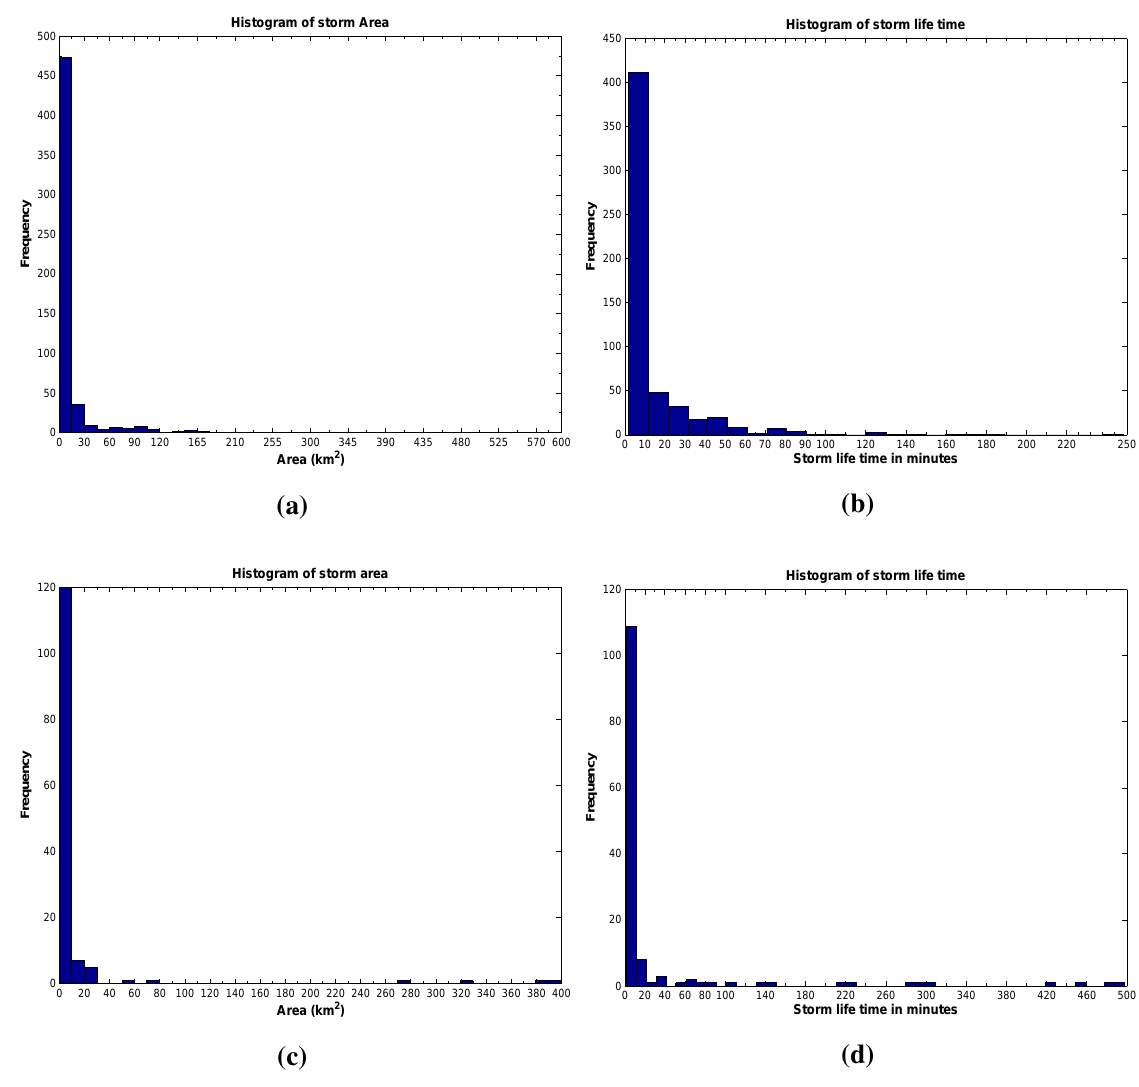
Figure 12. Histograms of the area and life time for convective events ( a , b ) and stratiform events ( c , d